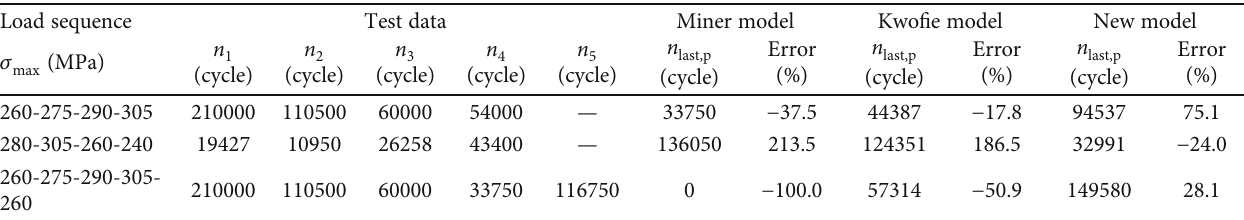
Figure 10: Geometry of 6082-T6 aluminium alloy specimens (dimensions in mm). Table 3: Experimentally obtained and corresponding theoretical remaining life values predicted by the Miner, Kwo fi e, and proposed new model for the 6082-T6 aluminium alloy under multilevel cyclic